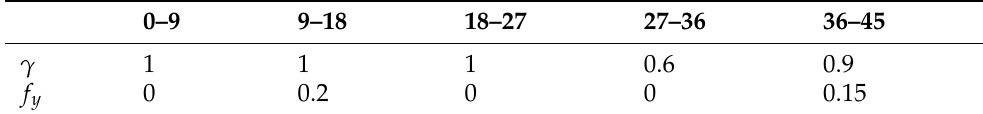
Table 4. Sensor faults applied in q 2 for the faulty